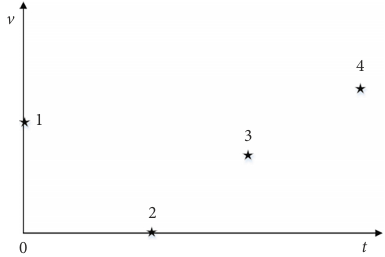
Figure 1. Vehicle dynamics at a signalized intersection Figure 2. Typical low-frequency